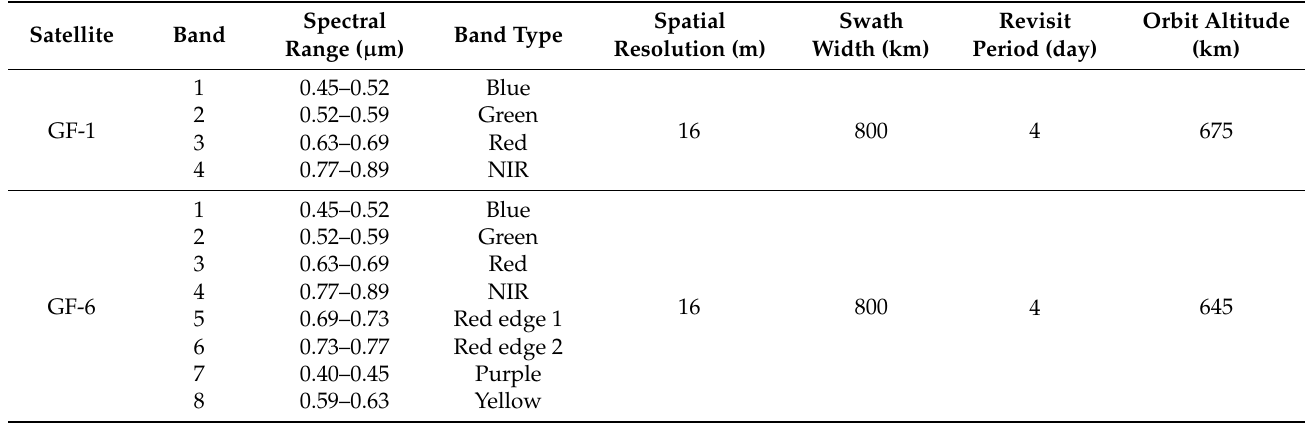
Table 2. characterization of Gao Fen (GF) wide field view (WFV) cameras.